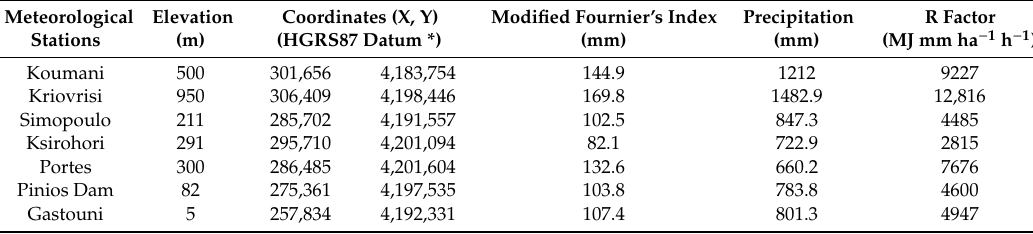
Table 1. The rainfall-runo ff erosivity factor (R) around the meteorological stations of the pilot area. Meteorological Stations